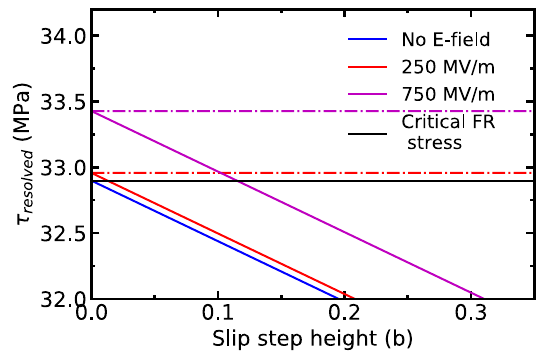
Fig 6. Solid lines correspond to relaxation in thermal stresses whereas dashed lines indicate fixed thermal stresses. As the step-induced enhancement is almost negligible in this regime of E fields, RSS in both types of steps evolves